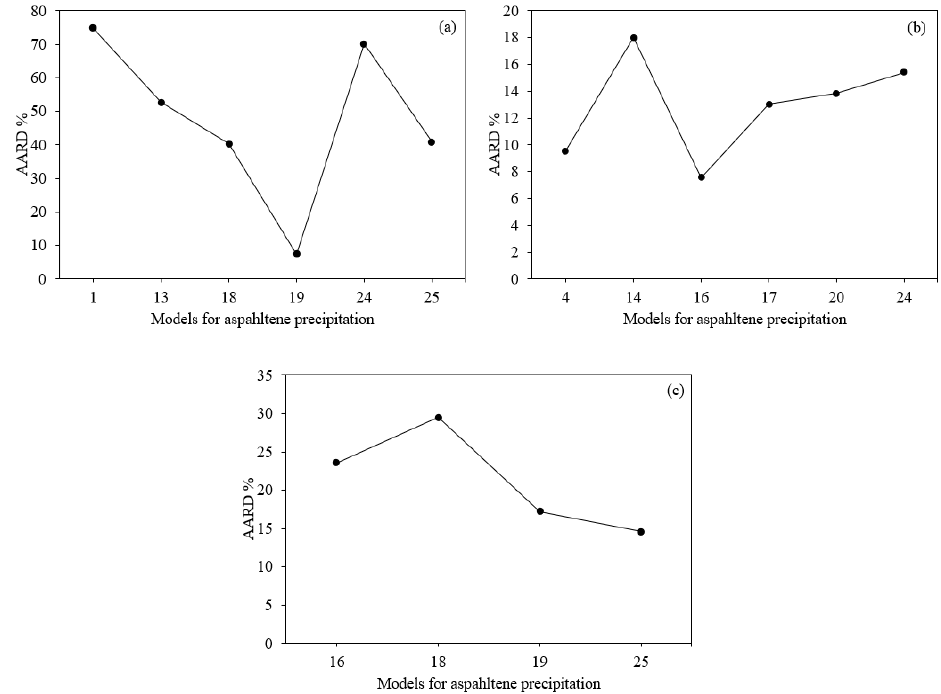
Figure 7. AARD% for different models to calculate asphaltene precipitation. ( a ) by effect of pressure and temperature changes. ( b ) by effect of addition of n-C 5 /nC 7 . ( c ) by effect of CO 2 injection.